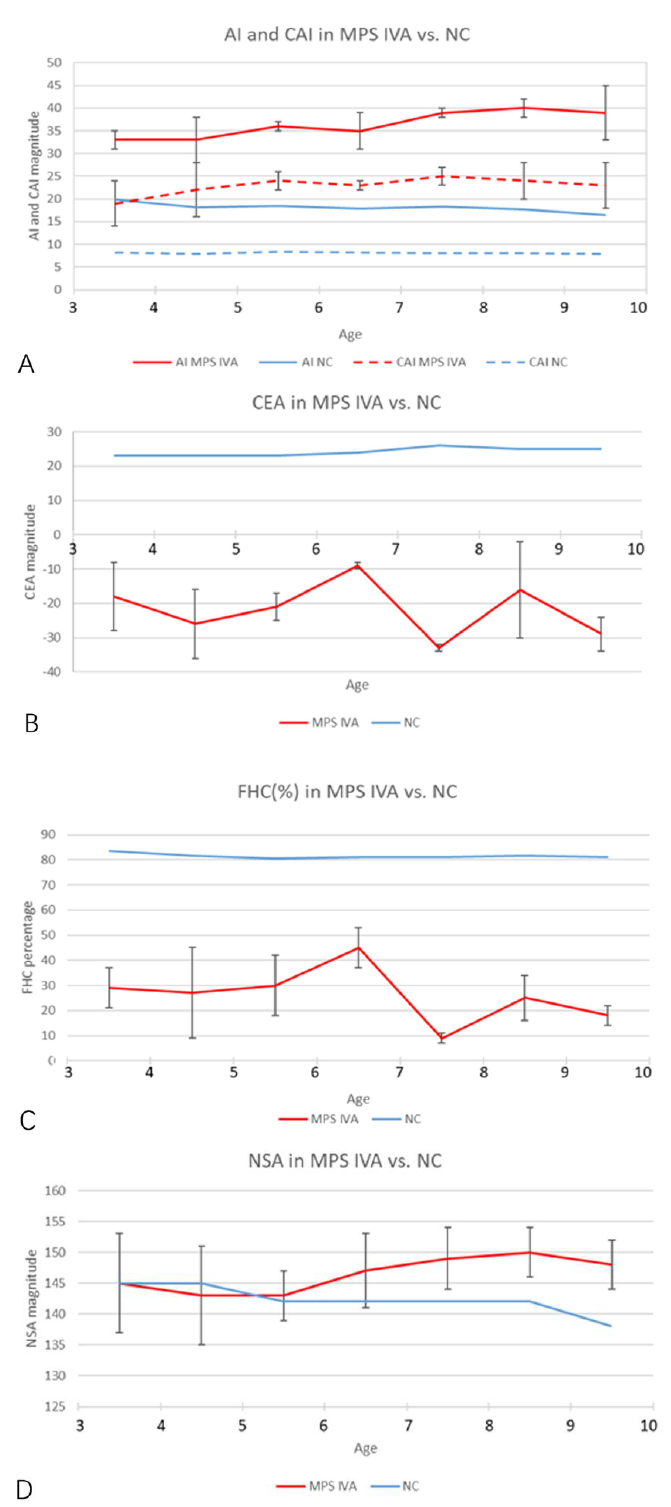
Figure 4. Age-matched comparison of each imaging parameter over 3 years old. ( A ) The AI and CAI magnitudes in MPS IVA hips (red and blue solid lines) increased significantly, compared with normal controls (red and blue dotted lines). Normal values of AI and CAI were cited from Li et al. [23]. ( B , C ) The CEA and FHC magnitudes in MPS IVA patients (solid red lines) decreased significantly, compared with normal controls. Normal values (solid blue lines) were cited from Tsukagoshi et al. [24]. ( D ) NSA (solid red line) in MPS IVA patients increased after 5 years old. Normal values (solid blue line) were cited from Birkenmaier et al. [25]. Note: NC, normal